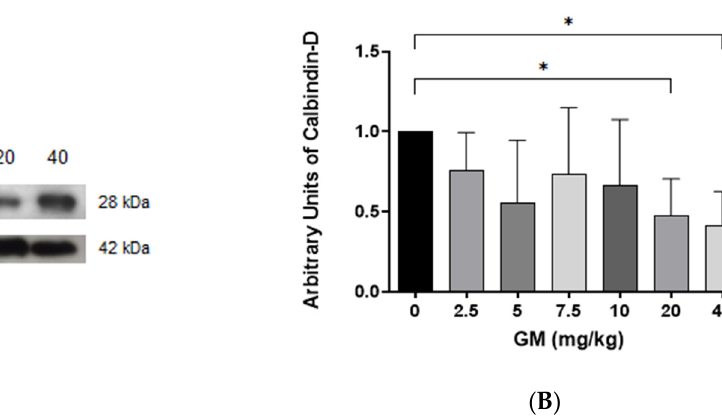
Figure 4. Calbindin-D protein levels in renal tissue decrease after GM administration indicating that DT injury occurs at GM doses >10 mg/kg. ( A ) Representative blot of Calbindin-D and β -actin from whole renal tissue of untreated and GM-exposed mice; ( B ) Bar graph shows means ± SD of normalized densitometries. n = 5 animals per dose. One-way ANOVA was performed, p = 0.0733. Post-hoc: Dunn test. * p < 0.05.